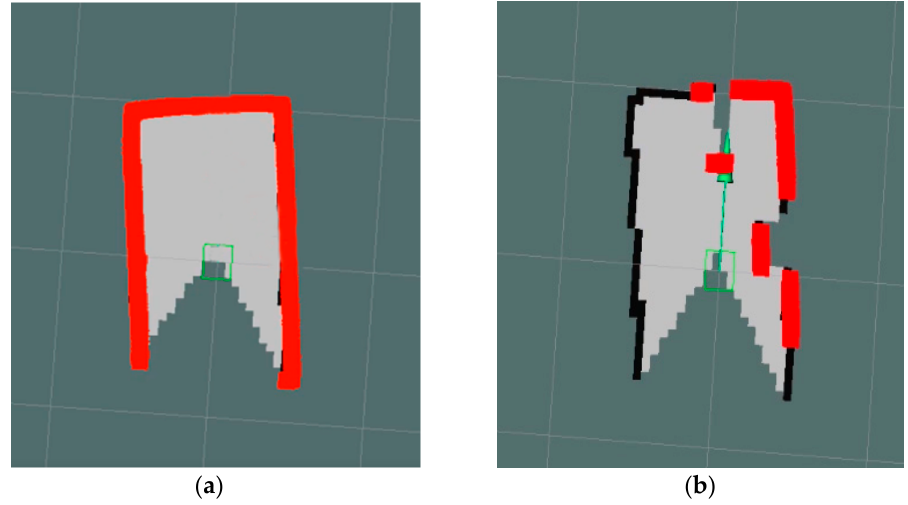
Figure 10. LiDAR mapping: ( a ) normal mapping; ( b ) missing LiDAR data.